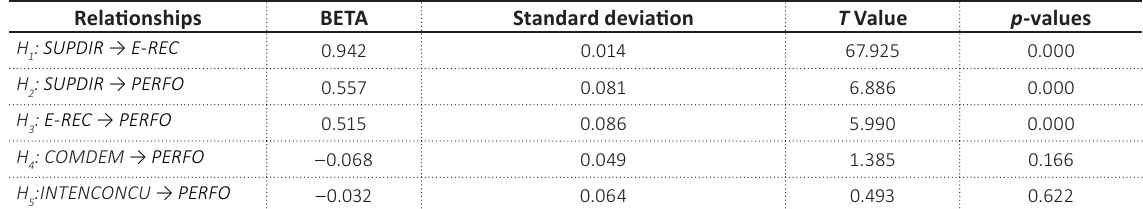
Table 3. Determining BETAs and test results Relationships